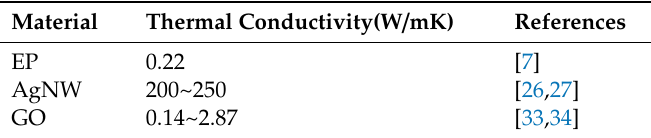
Table 1. Thermal conductivities of epoxy and